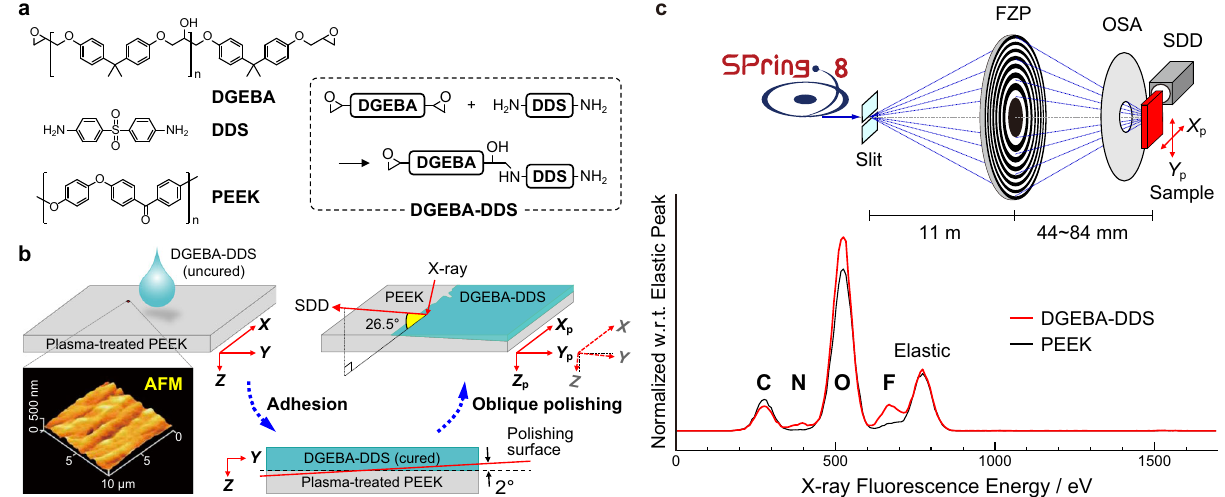
Fig. 1 Chemical and physical structures of the sample. a Chemical structures of DGEBA, DDS, PEEK, and the curing reaction of DGEBA-DDS. b Oblique polishing. The geometrical directions of the sample before polishing ( X , Y , and Z ) and after polishing ( X p , Y p , and Z p ) are indicated along with the corresponding illustration. Examination using an atomic force microscope (AFM) revealed hill-and-valley structures at the plasma-treated PEEK surface. Uncured DGEBA-DDS was adhered to the plasma-treated PEEK surface via the curing reaction of DGEBA-DDS. The cross-section of the DGEBA-DDS/ PEEK interface was exposed by polishing the X – Y plane of the adhered sample at the oblique angle of 2°. The depth distribution along the Z direction was re fl ected in the Y p direction. The TFAA treatment was applied to the exposed cross-section. XRF imaging was performed at the X p – Y p plane. c Microprobe XRF spectra ( hv = 780 eV) in the regions of DGEBA-DDS and PEEK. A soft X-ray beam from SPring-8 synchrotron radiation was focused by the Fresnel zone plate (FZP) and the order sorting aperture (OSA). XRF spectra were measured using a silicon drift detector (SDD). The XRF image was obtained by scanning the sample in the X p and Y p